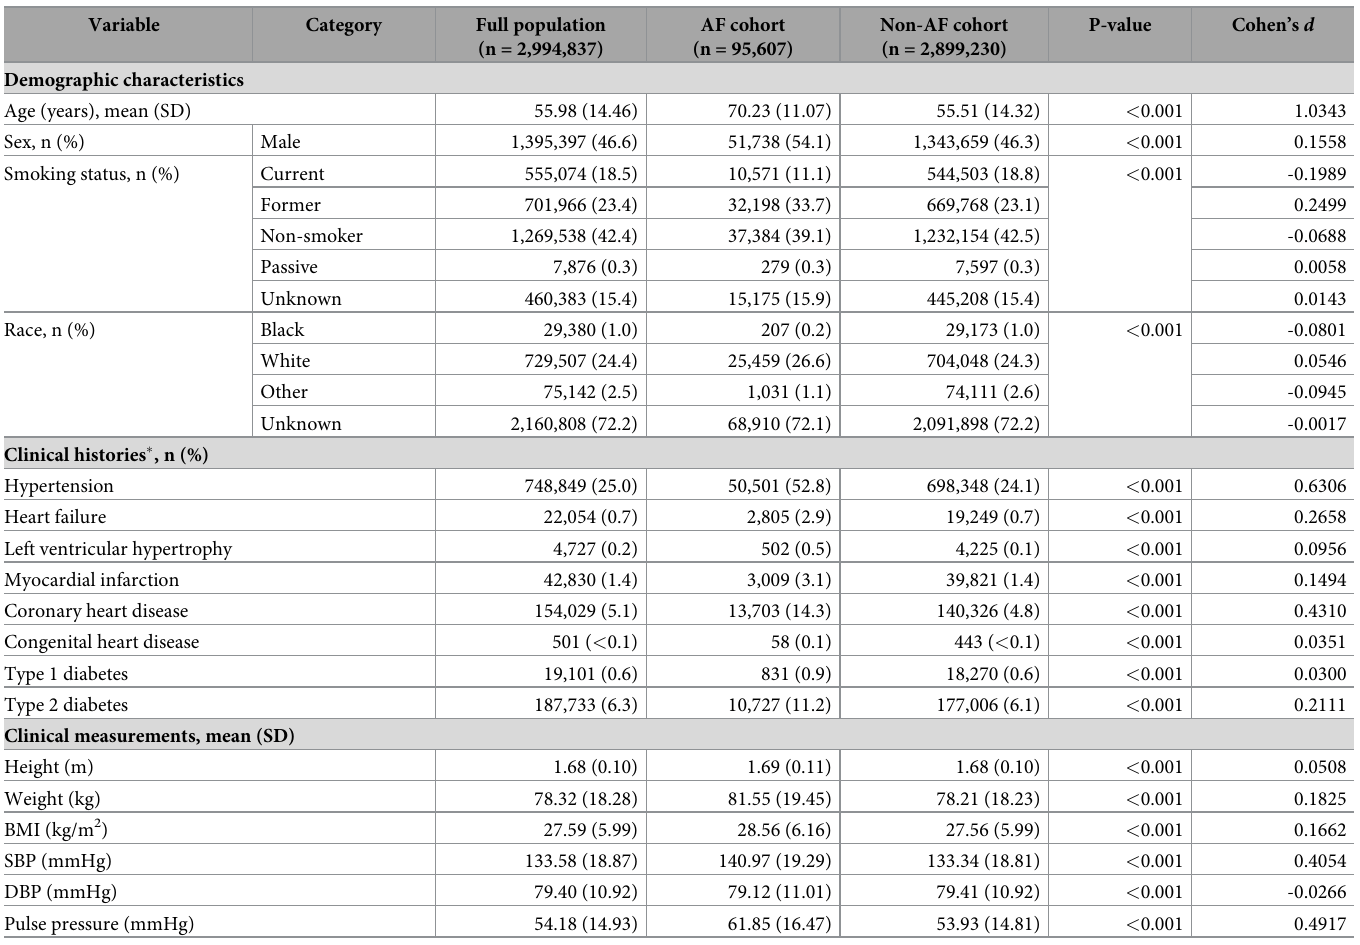
Table 1. Patient disposition at study